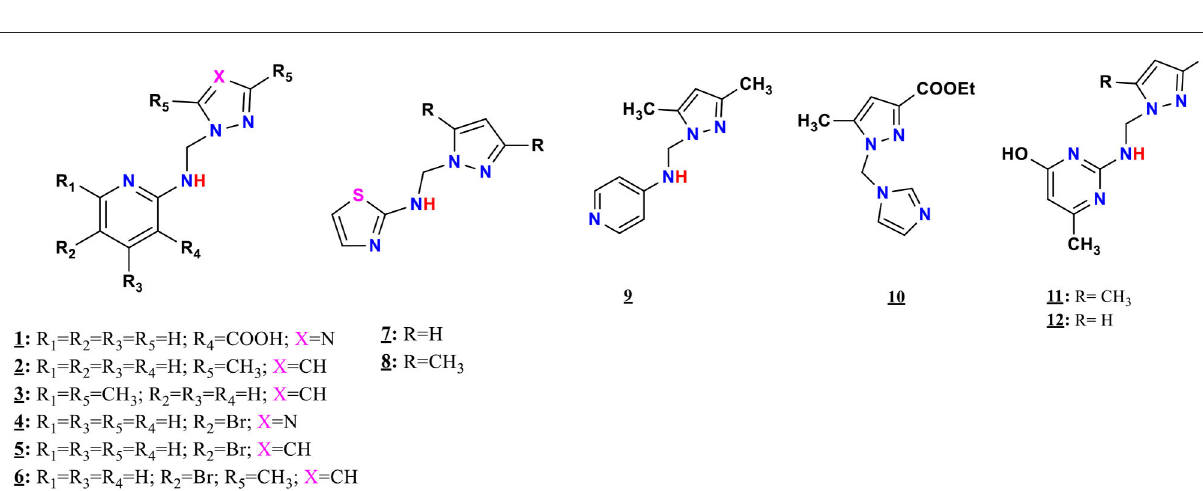
FIGURE 5 | Two-dimensional NMR COSY spectrum of N-((1H-pyrazol-1-yl)methyl)thiazol-2-amine, 7.